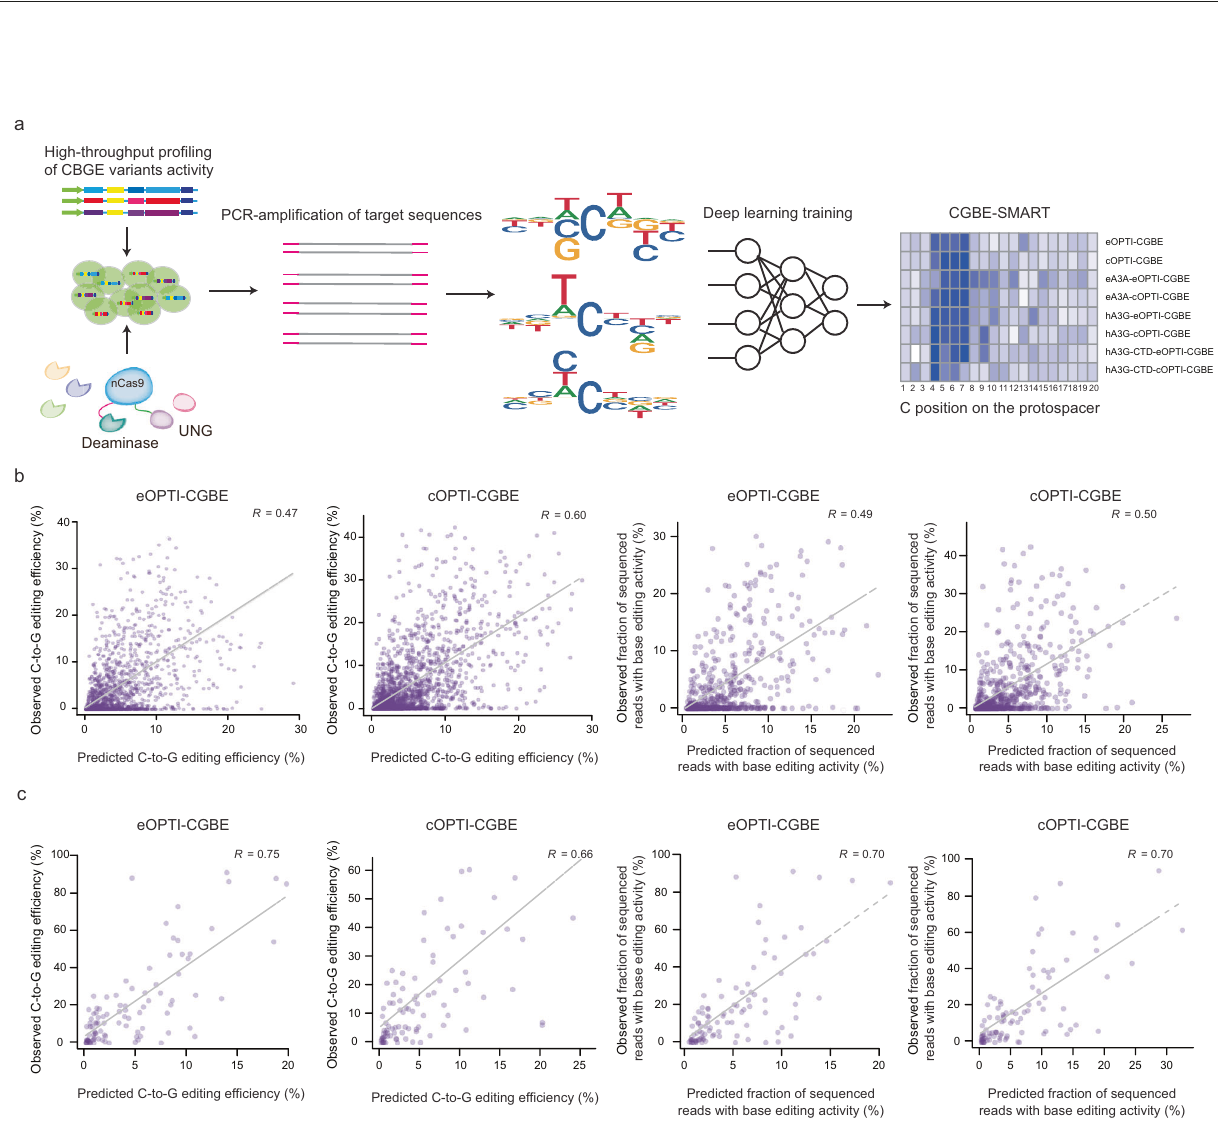
Fig. 2 Motif analysis of OPTI-CGBEs. a The C-to-G transversion ef fi ciency induced by eOPTI-CGBE or cOPTI-CGBE of targeted Cs bearing different nucleotides 1nt upstream. N = A, T, G, or C. P values above each group were calculated between the group with “ GCN ” group. b The C-to-G transversion ef fi ciency induced by eOPTI-CGBE or cOPTI-CGBE of targeted Cs bearing different nucleotides 1nt downstream. P values above each group were calculated between the group with “ NCG ” group. c Comparison of base editing ef fi ciency of eOPTI-CGBE or cOPTI-CGBE at “ WCW ” or other motif of the 34 original and 20 additional target sites. W = A or T. d Indel frequency of eOPTI-CGBE or cOPTI-CGBE at “ WCW ” or other motif of the 34 original and 20 additional target sites. e Comparison of C-to-G editing ef fi ciency of OPTI-CGBEs with eA3A deaminase at “ TCW ” or other motif of the 34 original and 20 additional target sites. f Comparison of C-to-G editing ef fi ciency of OPTI-CGBEs with hA3G or hA3G-CTD deaminase at “ CCN ” or other motif of the 34 original target sites and 26 additional target sites. The center line indicates the median, and the bottom and top lines of the box represent the fi rst quartile and third quartile of the values, respectively. Tails extend to the minimum and maximum values. n = 3 biological replicates for each site. All P values were calculated by two-sided Wilcoxon rank sum tests. g C-to-G editing ef fi ciency of each C induced by OPTI-CGBEs with hA3G or hA3G-CTD deaminase when the target sites had more than 2 Cs. n = 3 biological replicates for each site. Data are presented as mean values ± SEM. h Motif logo detected by a logistic regression model developed with a training dataset (80%) sampled from the detected base editing activities with the paired sgRNA library. The y -axis represents learned weights from the regression model for each nucleotide.